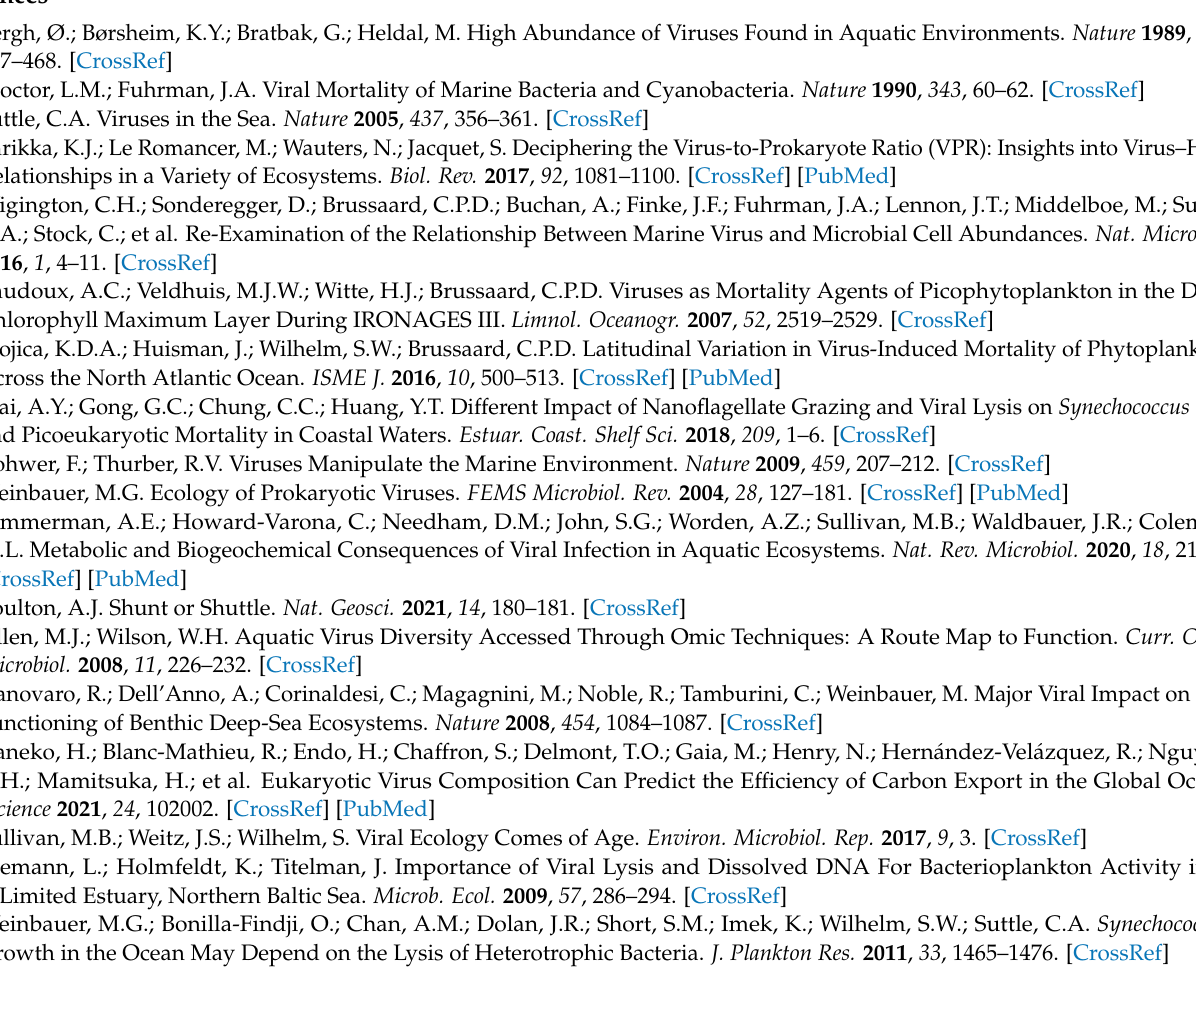
Figure S3. Cluster mapping in the nutrient ratio framework; Table S4. The ratio between HNA and LNA bacterial group; Figure S4. Abundances with average values; Figure S5. Log-log scatter plot of bacterial biomass and bacterial production; Figure S6. Relationship between the log abundances of heterotrophic nanoflagellates (empirical model by